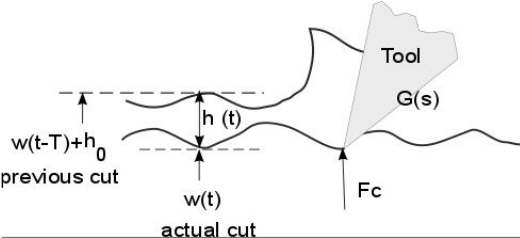
Figure 1. Two consecutive cuts, adapted from